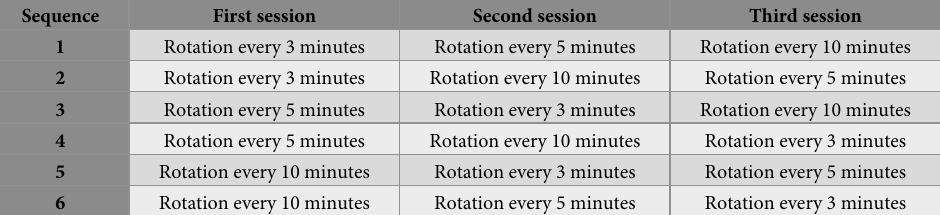
Table 1. Six variations in the sequence in which simulations were performed. Sequence First